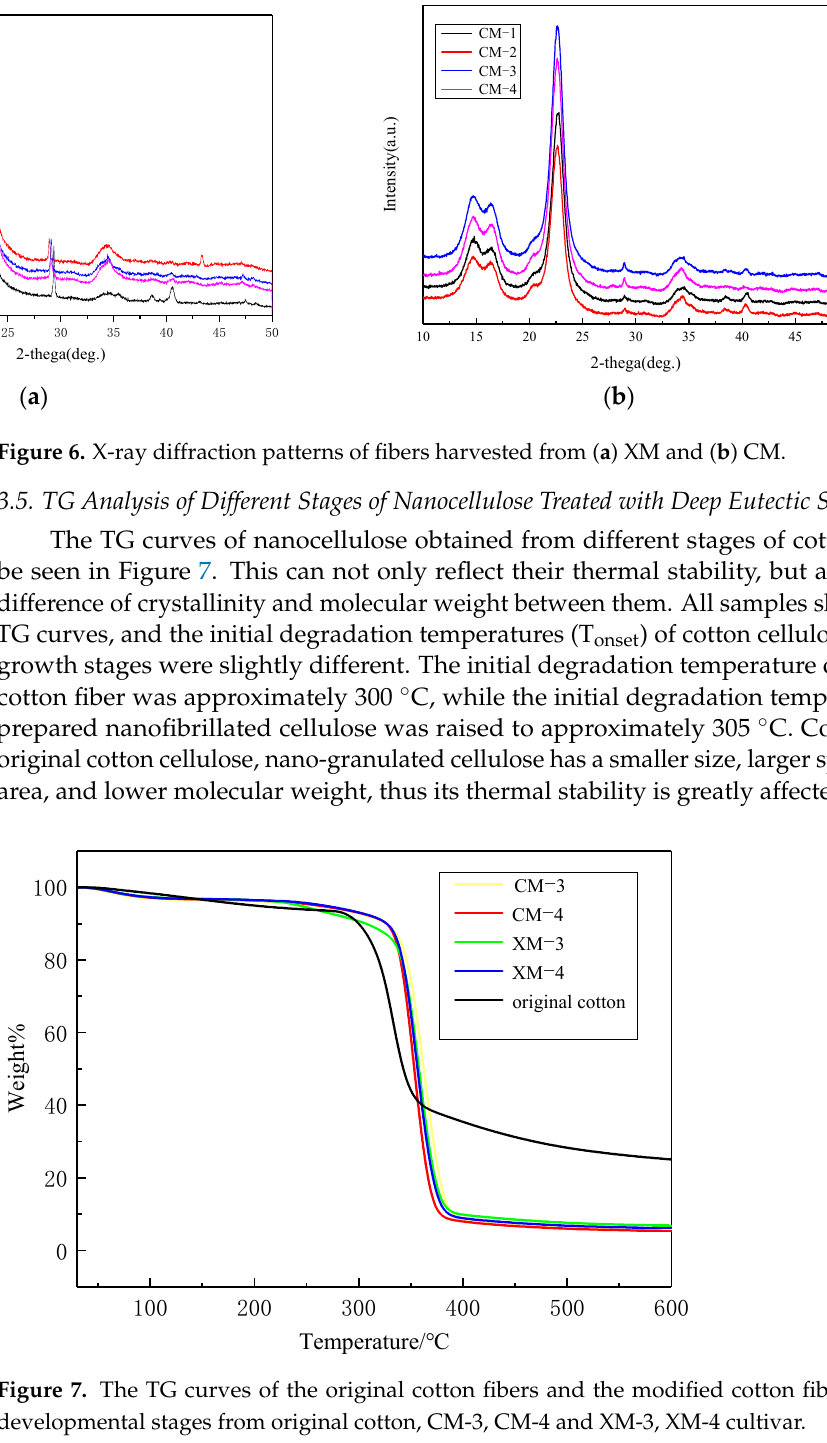
( b ) Figure 5. The dissolution process of ( a ): XM-3, ( b ) CM-3 in deep eutectic solvent. 3.4. XRD Analysis of Different Stages of Nanocellulose Treated with Deep Eutectic Solvent The X-ray diffraction (XRD) method was used to study the crystal structure and rel- ative crystallinity of nanocellulose. As shown in Figure 6, the characteristic diffraction peaks of nanocellulose at 2 θ of 14.2°, 16.8°, and 22.4° at different growth stages indicate that their crystal structure is cellulose I type. The results showed that the deep eutectic